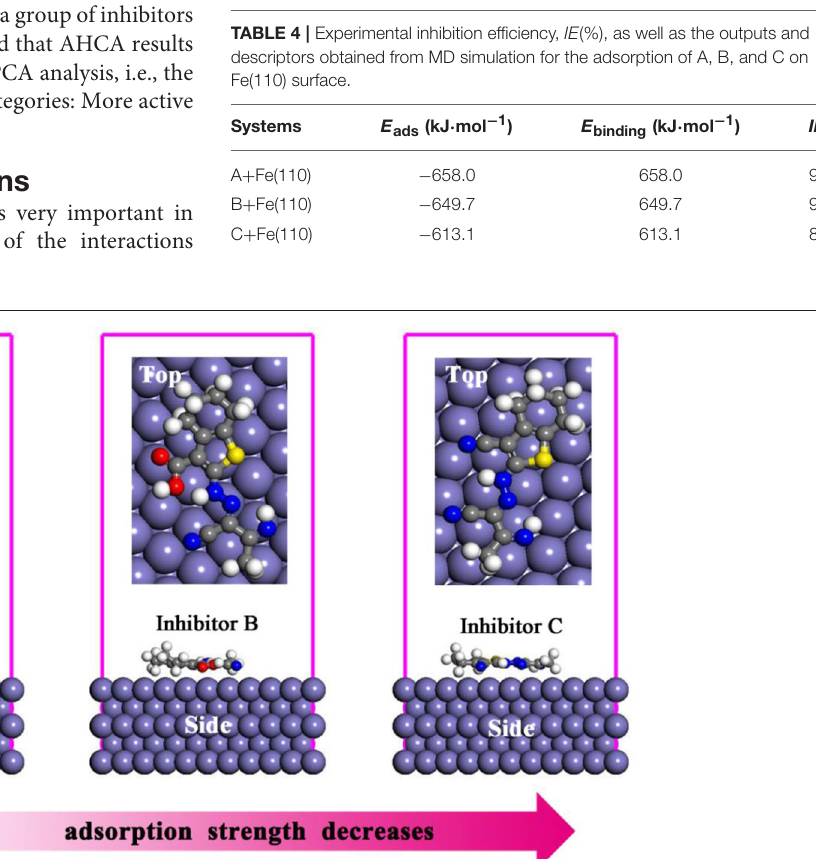
Frontiers in Chemistry |